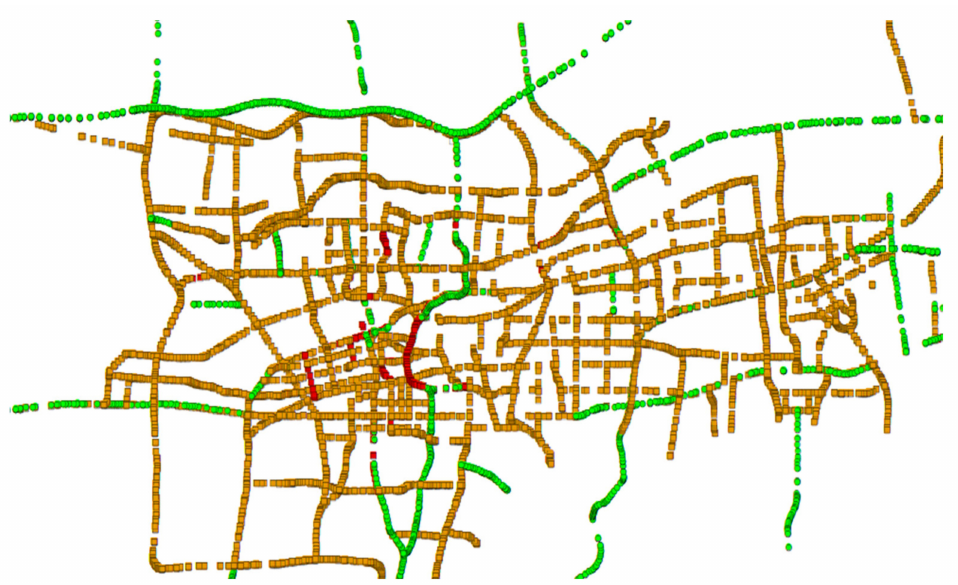
Figure 3. Road condition of early morning rush hour in Jinan city. (The closer the road color is to green, the smoother the road. The closer the road color is to red, the more congested it is).